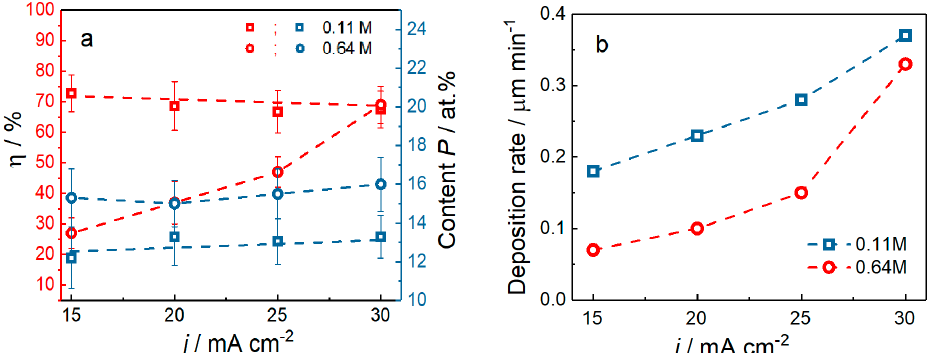
Figure 4. ( a ) The dependency of the current efficiency, η (grey symbols), and the phosphorous content (black symbols) in the Fe-P alloy coatings. ( b ) Dependency of the deposition rate on the cathodic current density, j . Variable parameter: Gly concentration. 60 °C.